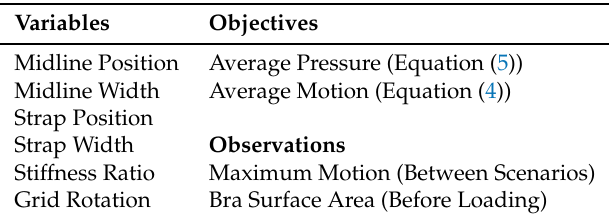
Table 5. Design space exploration variables and objectives.